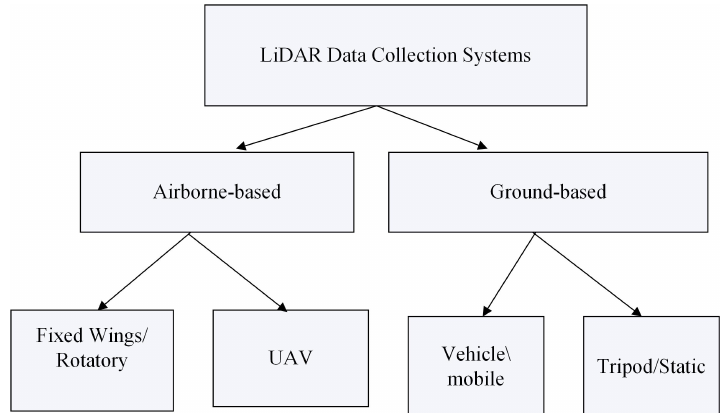
Figure 1. Different LiDAR data collection